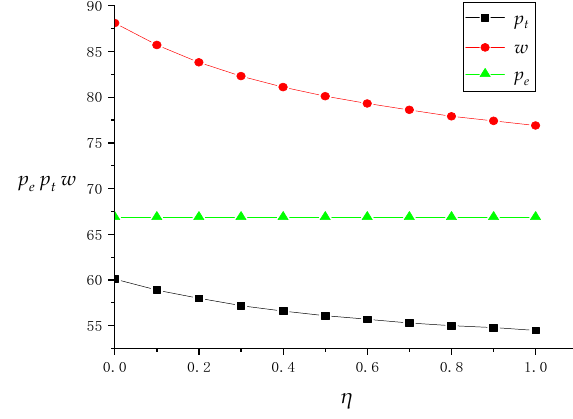
Figure 4. The change of prices as η increases.